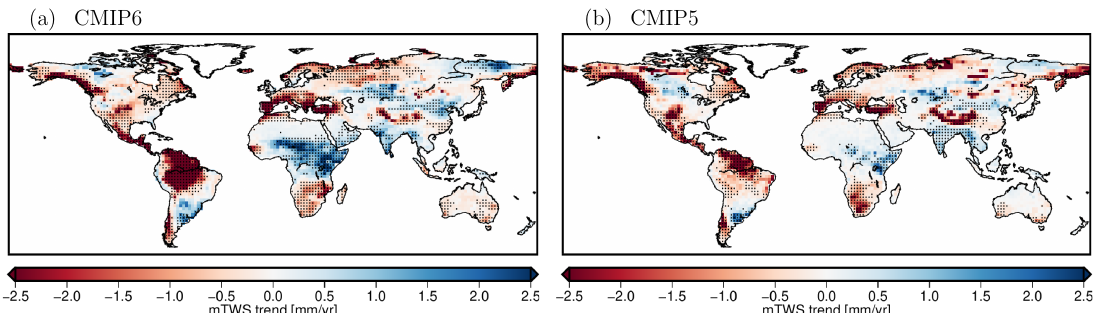
Figure 10. ( a ) MMMed mTWS linear trend over 2000–2100. Stippling indicates regions where 13 or more of 17 models (i.e., ≥ 76%) agree on the sign of the trend. ( b ) same as ( a ) but for 17 CMIP5